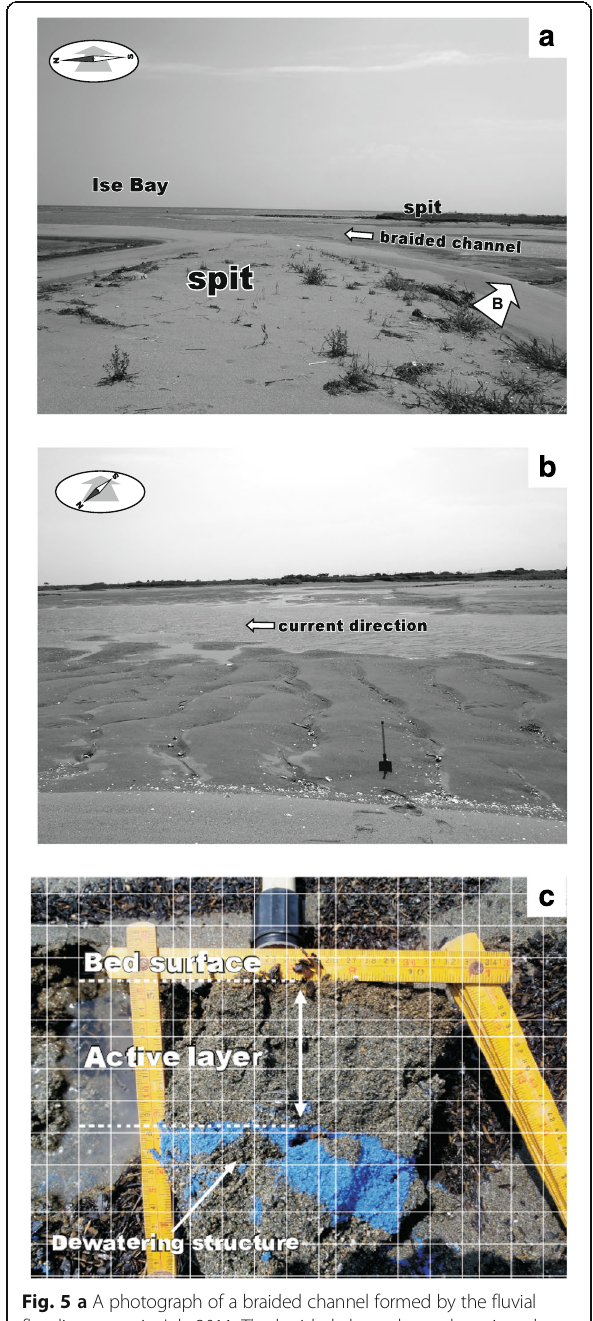
Fig. 5 a A photograph of a braided channel formed by the fluvial flooding event in July 2011. The braided channel cuts the spit and flows into the tidal sand flat. b Dunes in the braided channel. The left side of the photo is seaward. c The appearance of the active layer observed at point 3 soon after the fluvial flooding (August 1,